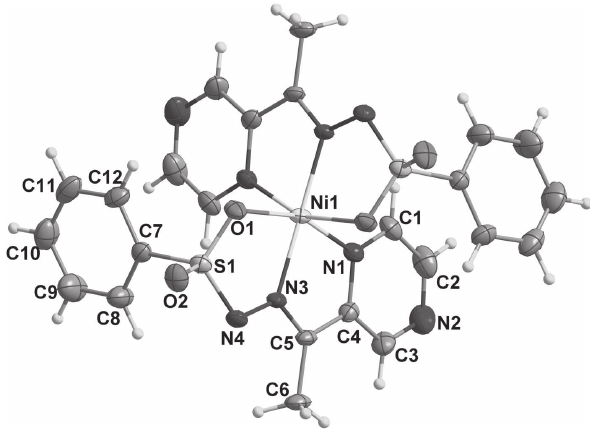
Table 1: Data collection and handling.